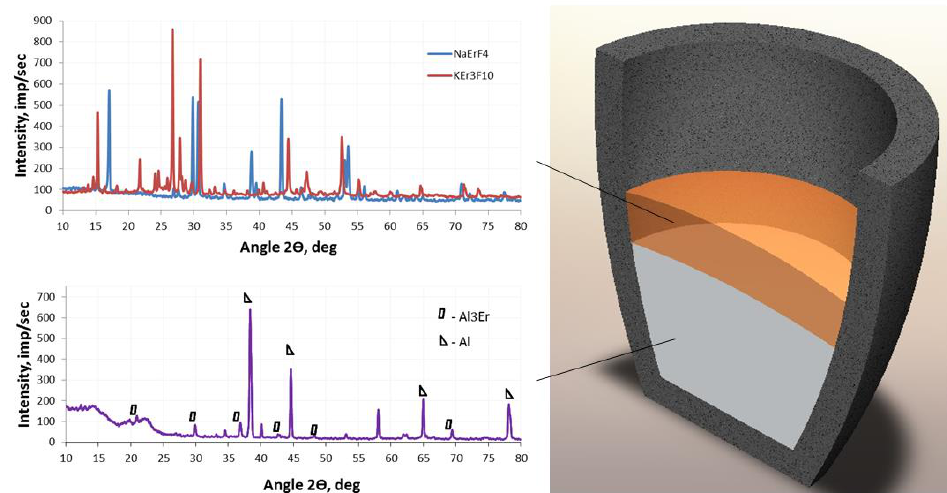
Figure 1. Diagram of the location of melts during aluminothermic preparation of master alloy and radiographs of components.